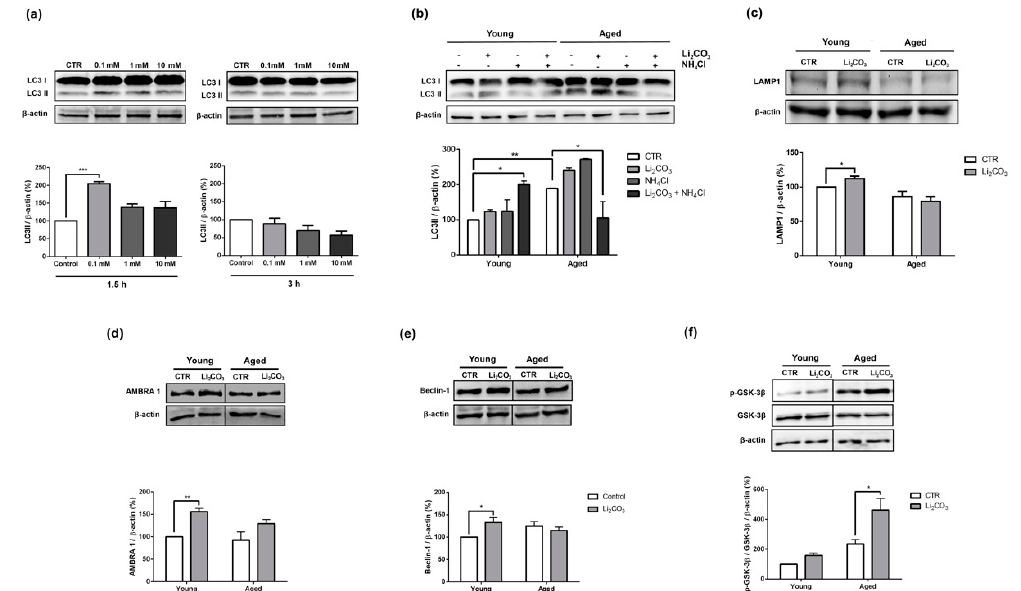
Figure 1. Lithium blocked autophagy in striatal slices of aged rats, possibly by GSK-3 β inhibition. ( a ) Young animals striatal slices were treated with several concentrations (0.1, 1 and 10 mM) of Li 2 CO 3 for 1.5 h and 3 h, and the LC3-II expression was detected by Western blotting. ( b ) LC3-II expression levels were detected by Western blotting after 1.5 h of 0.1 mM Li 2 CO 3 treatment in the presence or absence of NH 4 Cl (4 mM) in young and aged animals. ( c ) LAMP 1, ( d ) Ambra 1, ( e ) Beclin-1, ( f ) p-GSK-3 β (Ser 9) and GSK-3 β expressions levels were detected by Western blotting after 1.5 h of 0.1 mM Li 2 CO 3 treatment in striatal slices of young and aged animals. Representative Western blot autoradiographies are shown on the top panels and the histograms showing mean ± standard error of the mean (SEM) of bands’ relative density are shown on the bottom panels. All values were normalized to β -actin and expressed as percentages of the control young animals (100%) ( n = 2–4). ( a ) * p < 0.05 compared to control (one-way ANOVA, Dunnet post-hoc); ( b , d – f ) * p < 0.05 or ** p < 0.01 compared to control (one-way ANOVA, Bonferroni post-hoc); ( c ) * p < 0.05 compared to control (Student’s t